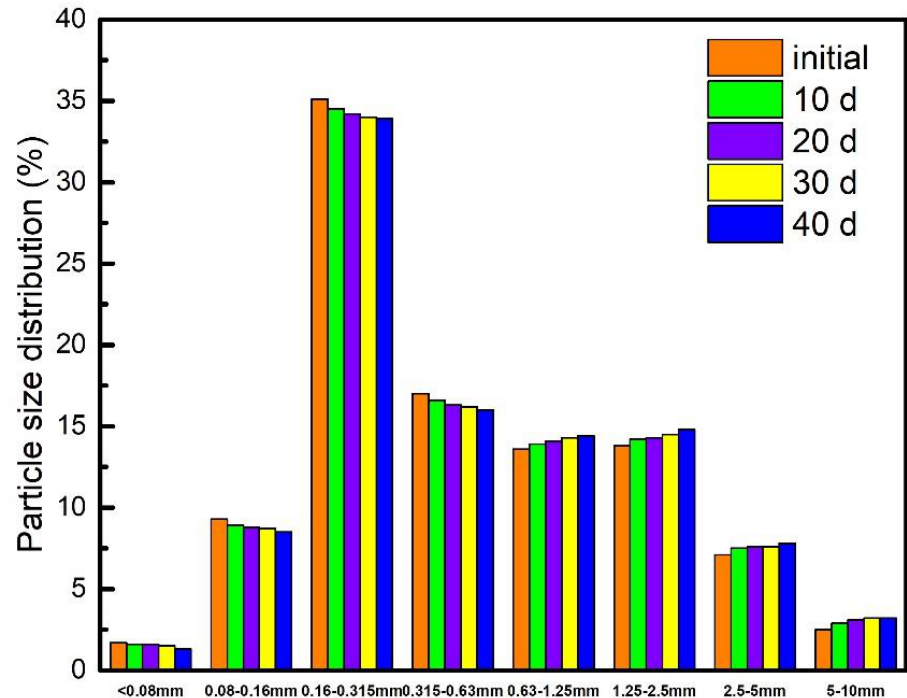
Figure 4. Change in particle size distribution of filter layer (0–50 mm) during operation.